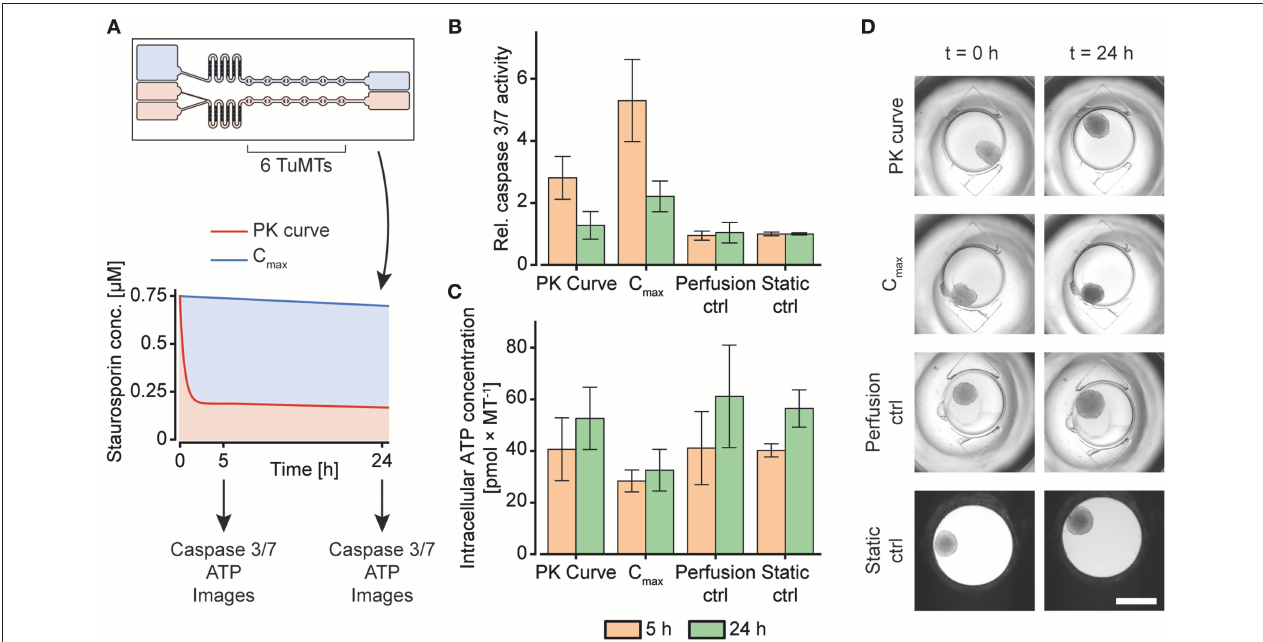
FIGURE 6 | Staurosporine treatment of human colorectal tumor (HCT 116) microtissues (TuMTs) in the microfluidic chip. (A) Experimental layout: A chip was used to expose six TuMTs per channel to a PK-like dosing profile or a constant dose. The initial maximum concentration (C max ) of the PK-like profile was chosen as the constant concentration for the second channel. The perfusion control and the static control MTs were cultured without any compound treatment in the chip and in a 96-well microtiter plate, respectively. Readouts were taken 5 and 24h after treatment start. (B) Relative caspase 3/7 activity, normalized to those of the static control of the respective sampling time points (data represented as mean ± SD; n = 6–12 TuMTs). (C) Intracellular ATP concentration as a measure of viability (data represented as mean ± SD; n = 6–12 TuMTs). (D) Representative images of TuMTs on the chip and in the microtiter plate at 0 and 24h (scale bar: 500 µ